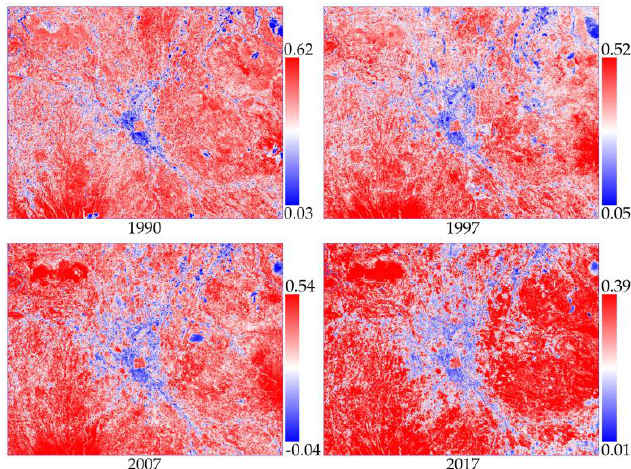
Figure 11. Normalized Difference Vegetation Index (NDVI) distribution maps.